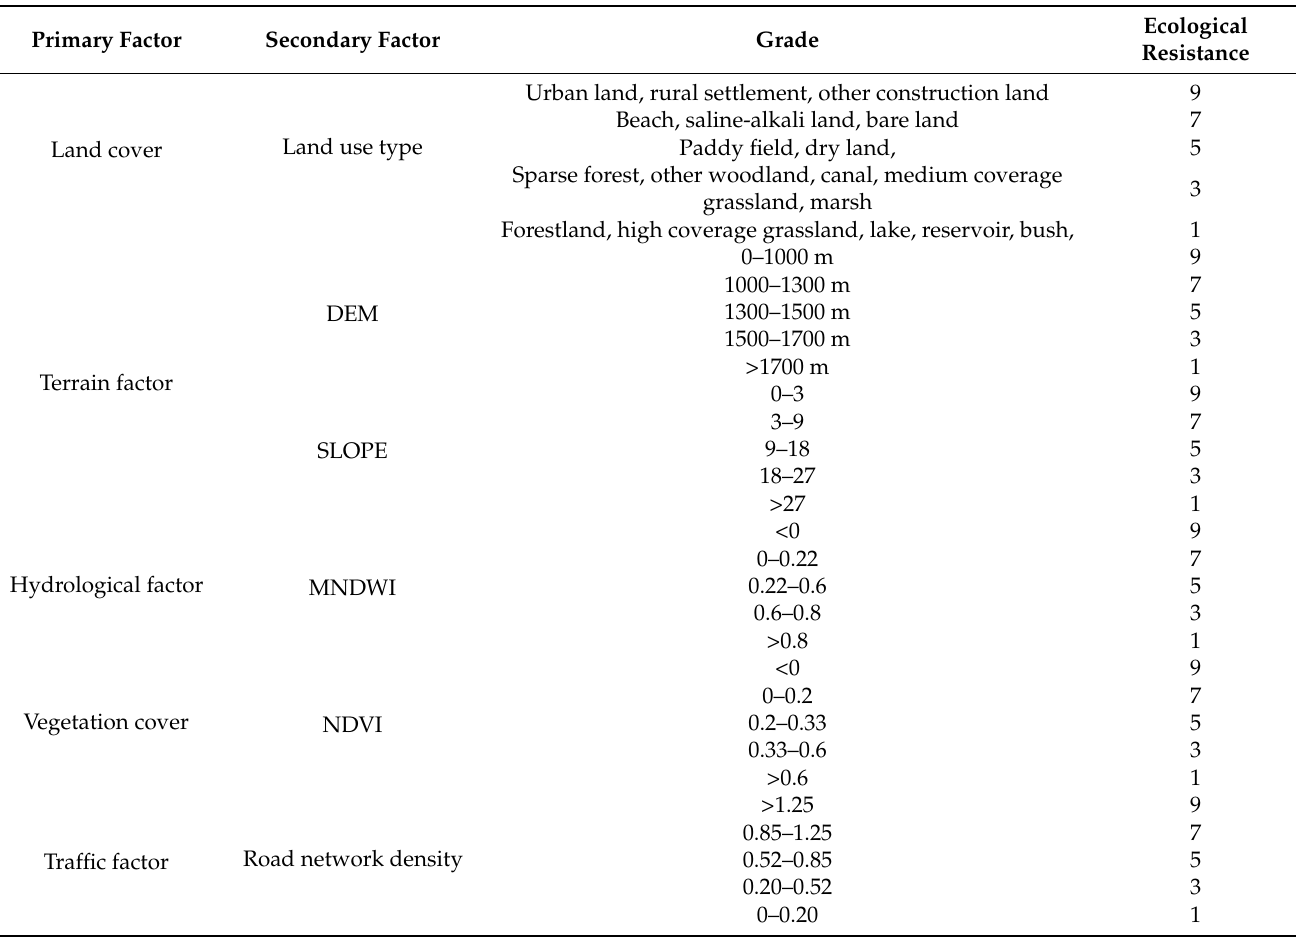
Table A1. Ecological resistance evaluation